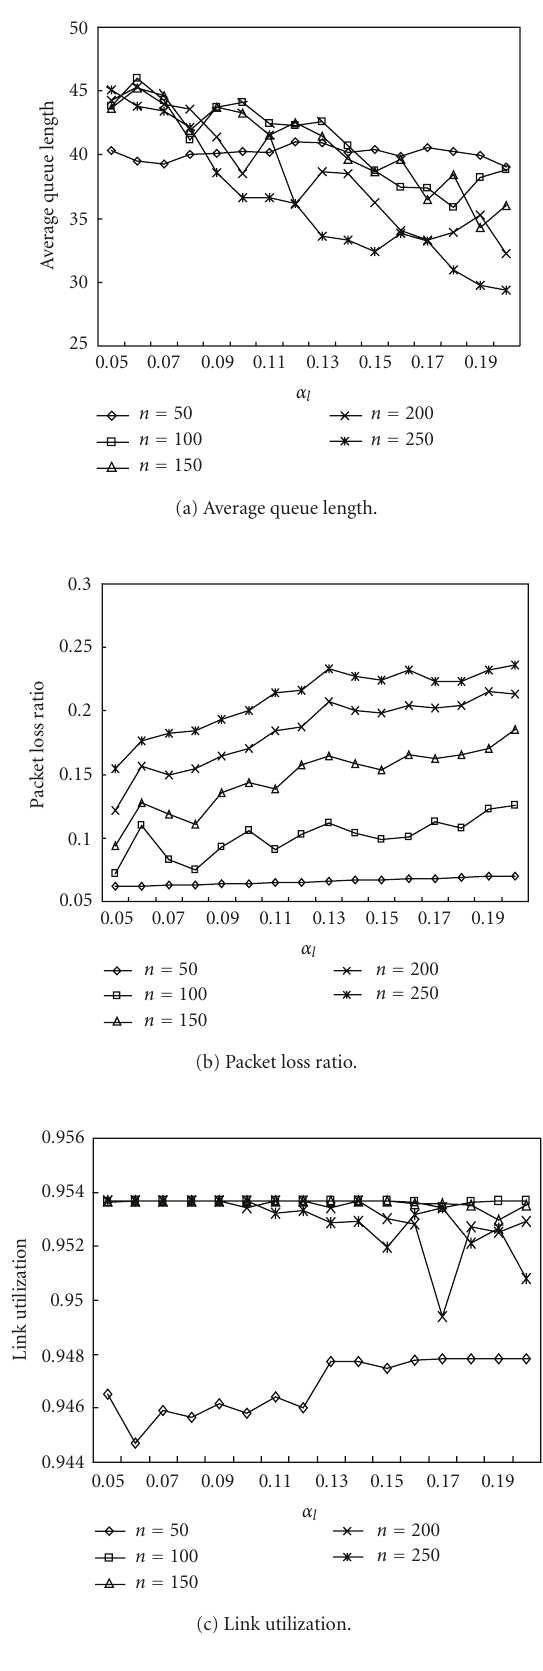
Figure 2: Performance using di ff erent α l